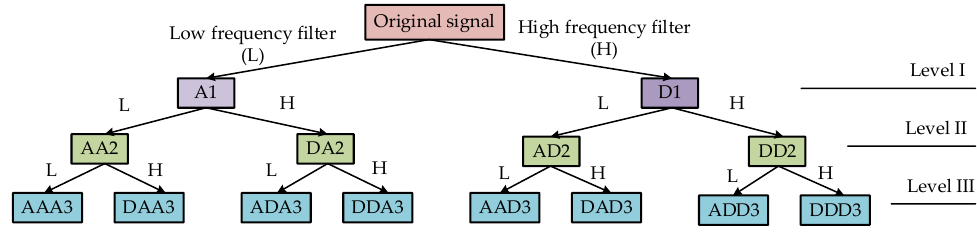
Figure 3. Structure of wavelet packet transform.